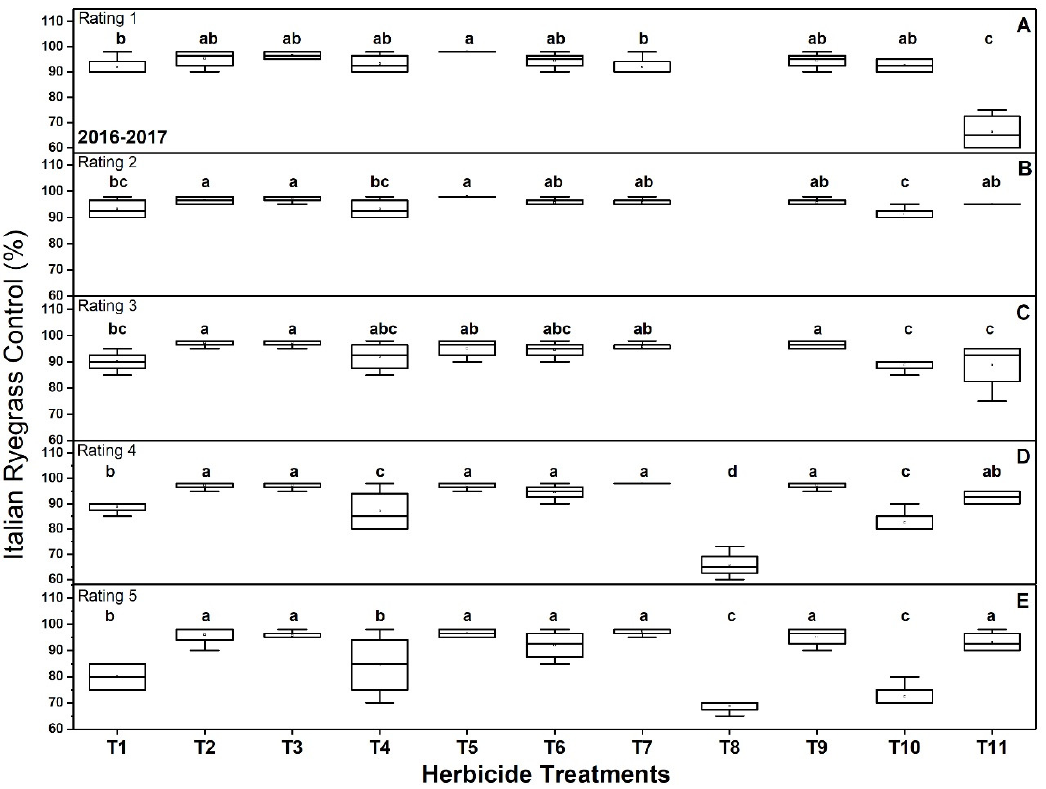
Figure 1. Glyphosate-Resistant Italian ryegrass Control Study in 2017 showing percent weed control.